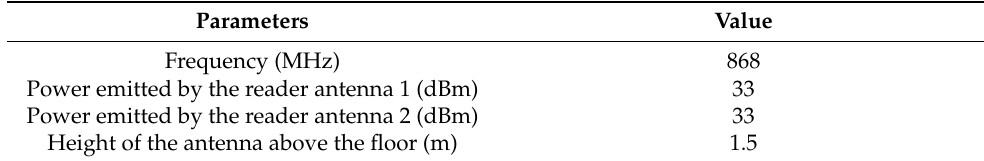
Figure 8. Position of light sources in the scene. Red dot for antenna 1, blue dot for antenna 2. Table 2. Parameters of the RFID antennas.